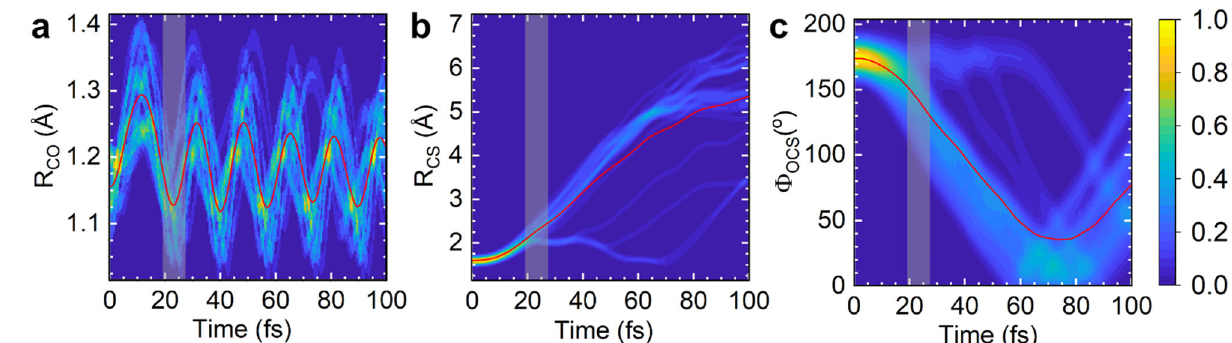
Fig. 5 Dynamical calculations of fi eld-free neutral OCS. a – c Mixed quantum-classical nuclear dynamics calculations of neutral fi eld-free OCS that is slightly bent as a function of time after excitation of the neutral molecule, t . Dynamical results are shown along the C – O ( a ) and C – S ( b ) internuclear distance coordinates, R CO and R CS , respectively, and the O – C – S bond angle ( c ) coordinate, Φ OCS . The average value of over 20 trajectories is shown as a red line. The dynamical calculations best reproduce our measured LIED structure at a time window of t = 19.5 − 27.0 fs (shaded grey regions) corresponding to R CO = 1.13 Å, R CS = 2.29 Å and Φ OCS =